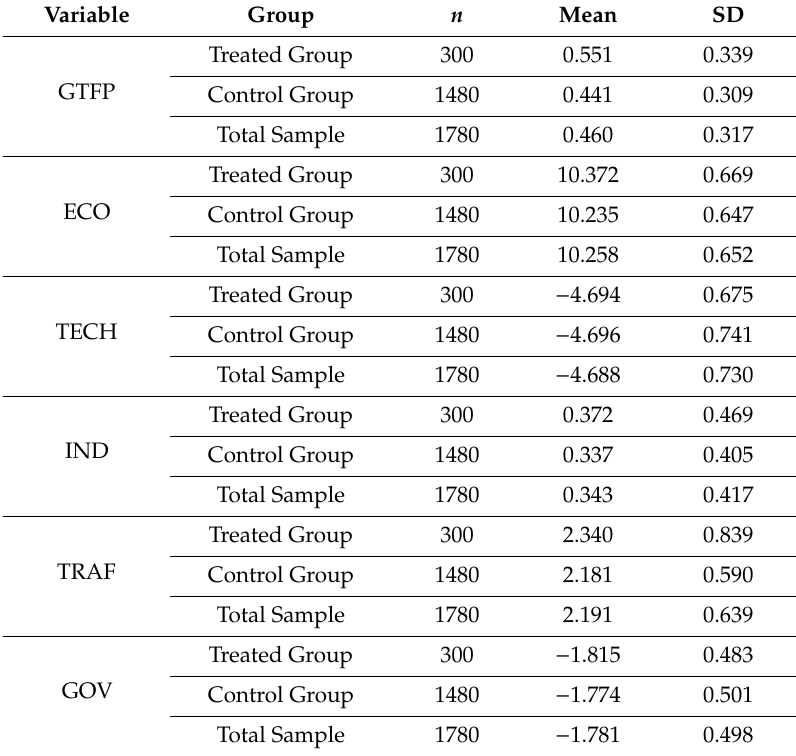
Table 1. Description of main